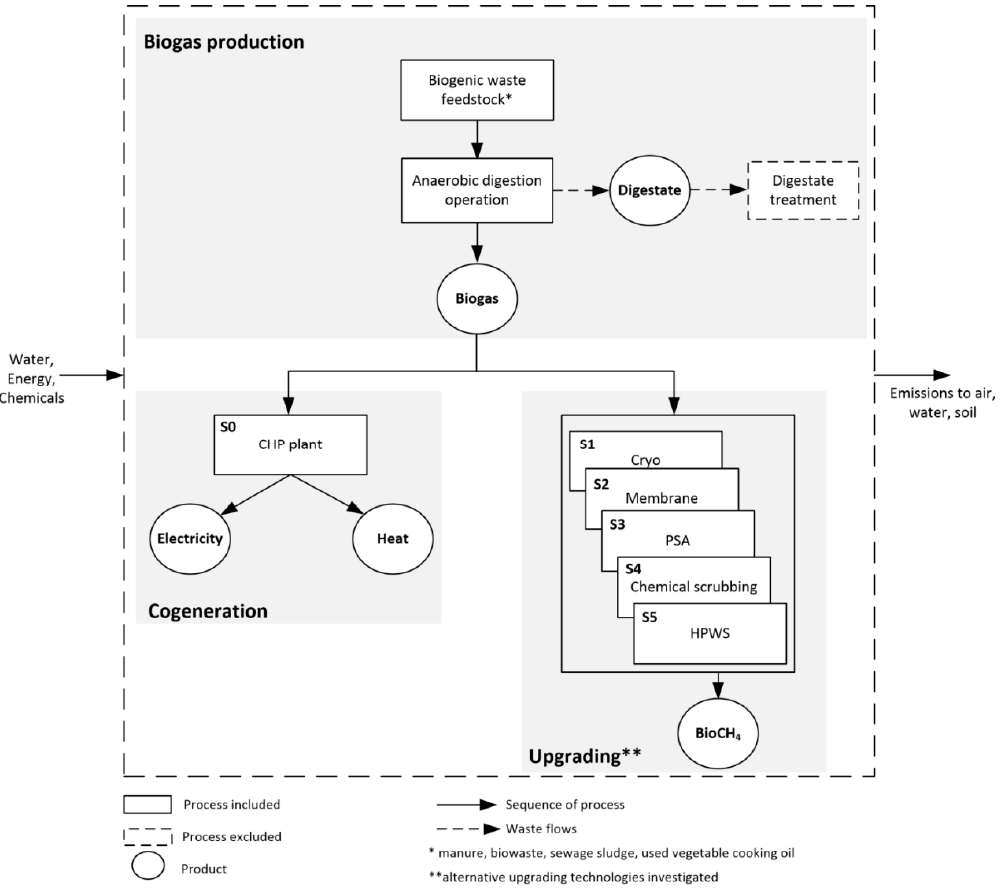
Figure 1. Schematic flowchart of the investigated system (the dotted line indicates the system boundary).